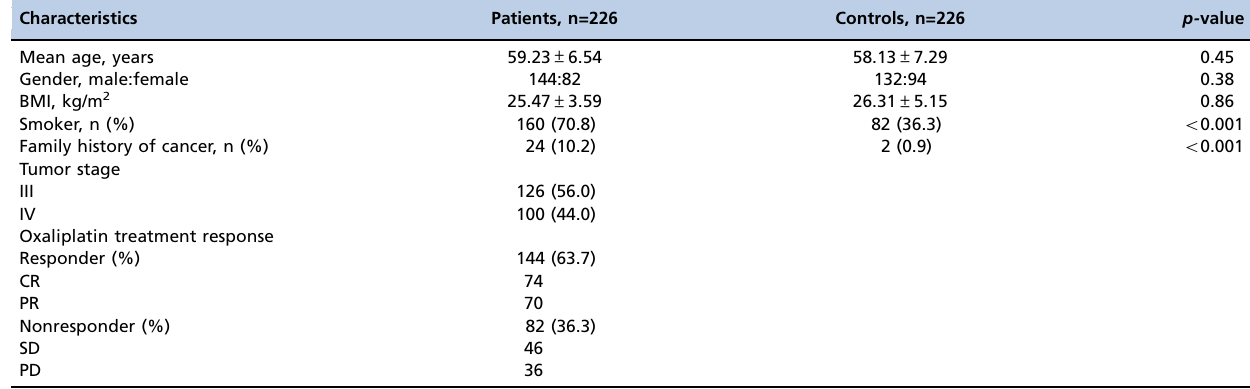
Table 1 - Demographic and basic clinical characteristics of the patient and control groups. Characteristics Patients, n=226